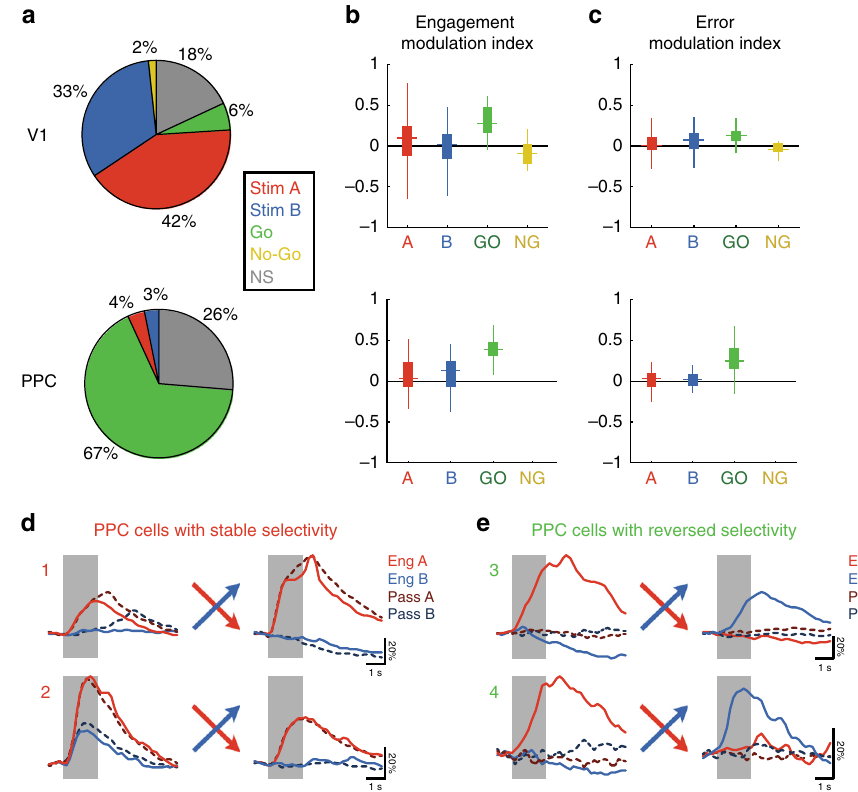
Fig 8 PPC cells with reversed selectivity exhibit stronger modulation by engagement and by error trials. a Proportion of signi fi cantly responsive V1 (top) and PPC (bottom) neurons with stable stimulus selectivity (Stim A, 0°; or Stim B, 90°) or reversed selectivity (Go or No-Go). Cells with non-signi fi cant selectivity either before or after reversal are categorized as non-selective (NS). b Boxplots (with center line as median, box as interquartile range, and whiskers as 1.5 × IQR) of engagement modulation index for each response group, computed as the mean before and after reversal. “ Go ” -selective neurons (green) show stronger engagement modulation, i.e., weaker passive responses, than stimulus-selective neurons (red or blue). c Boxplots of error modulation index for each response group, computed by comparing False Alarm trials with Correct Reject trials both before and after reversal. “ Go ” - selective PPC neurons show stronger error modulation (green) than stimulus-selective neurons (red or blue). d Responses of two PPC neurons with stable selectivity to Stimulus A both before and after reversal of reward contingency. Colors indicate stimulus (red, A; blue, B) and dark, dashed lines indicate passive trials. These neurons show a robust passive response in both conditions, and have a low engagement modulation index. e Same as d but for two PPC neurons with reversed selectivity after reversal of reward contingency. These neurons show virtually no passive response in both conditions, and